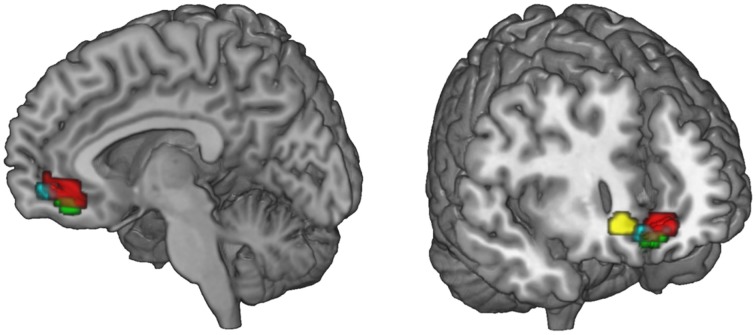
Summary of the functional connectivity results. WTP is correlated with voxels in the vmPFC (red, parametric modulation analysis, GLM 2). As WTP is higher for FT products, it is of interest to find out which regions exhibit increased task-related (FT vs. conv) functional connectivity with the vmPFC. We find that the superior frontal gyrus (green) and the ventral striatum (cyan) exhibit increased task-related connectivity in response to FT labels with the vmPFC (p < 0.05, small-volume FWE corrected). The ACC also exhibits increased task-related connectivity, but with a more lateral portion of the vmPFC that is not shown in the left slice. Data are shown using MRIcroGL (MNI template) and in radiological convention.